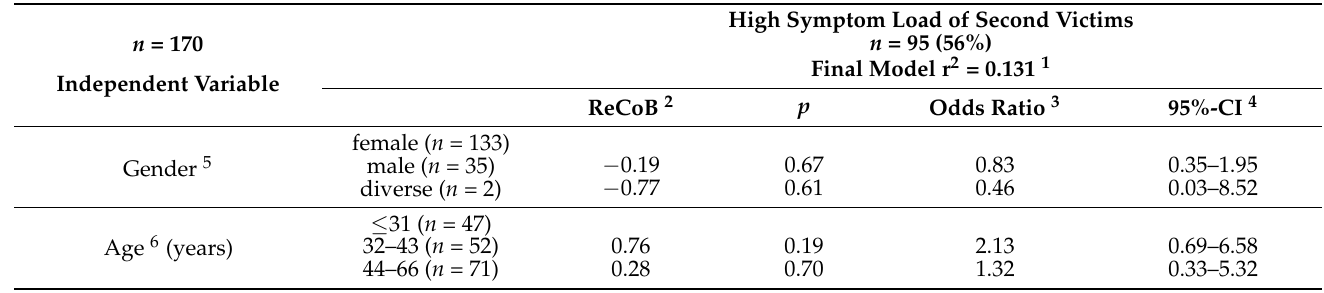
Table 5. Factors influencing the symptom load of second